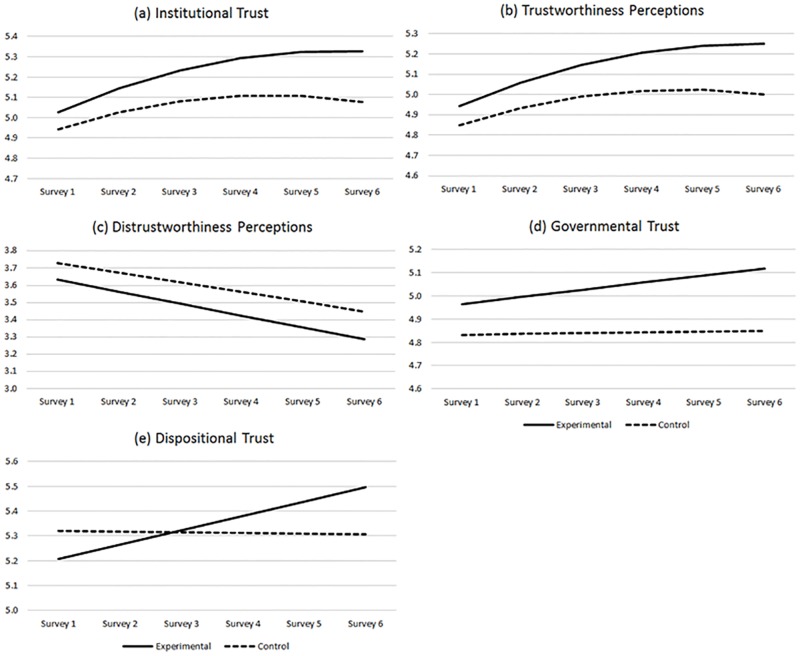
Predicted levels of key variables over time for the control and experimental groups.Notes. Predicted values were based on univariate models including time and information manipulation conditions as described in the text. There were no significant differences in the trajectories of the control and experimental groups in Figs 2a-2d. There was a significant difference in slopes for Fig 2e.